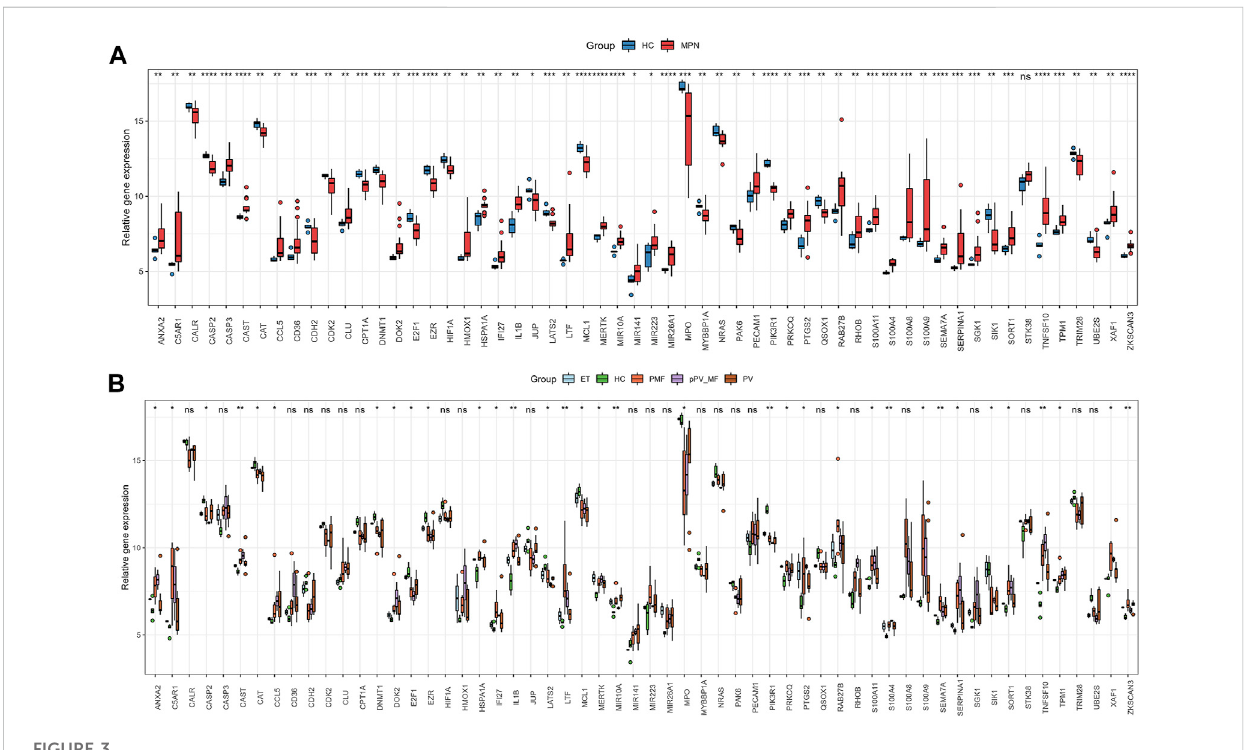
FIGURE 3 Expression of 58 anoikis-related DEGs in MPN (A) and subtype clusters (B)